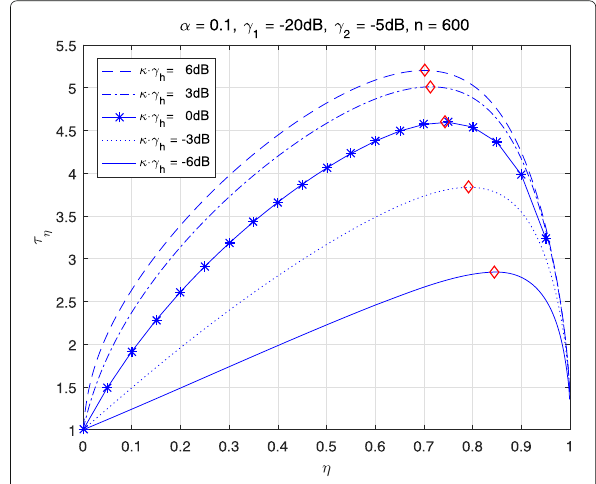
proposed in this paper. False alarm and missed detection probabilities of the proposed scheme were analyzed. How to determine its relay policy was also investigated. Taking the criterion of balancing detection accuracy for example, closed-form expression, lower bound, and upper bound of the optimal relay policy were deduced. We proved that, in order to avoid either of SUs causing too much inter- ference, the SU with higher SNR should spend at least 42.9% and at most 87.2% of its detection period acting as the relay node. Considering the criterion of maximizing detection agility, we showed that, although the perfor- mance of relaying SU was inevitably impaired, detection agility of the whole CR network could be improved by as much as 630% via choosing an optimal relay